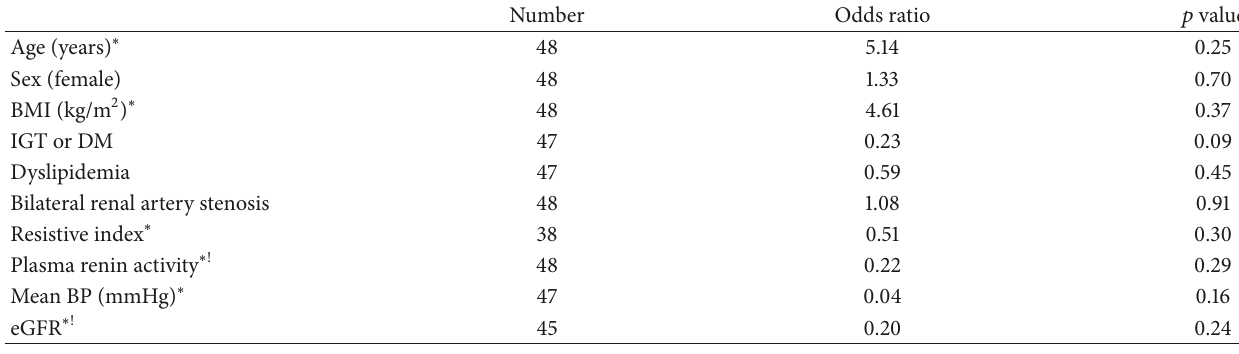
Table 2: Univariate analysis of predictive and confounding factors for successful reduction of blood pressure. Successful reduction of BP was defined as reduction in mean BP of 5 mmHg or more, or reduction of antihypertensive dose. ∗ Logistic regression analysis, other parameters were analyzed with the chi-square test. ! Plasma renin activity and eGFR were analyzed after log conversion. BP: blood pressure; BMI: body